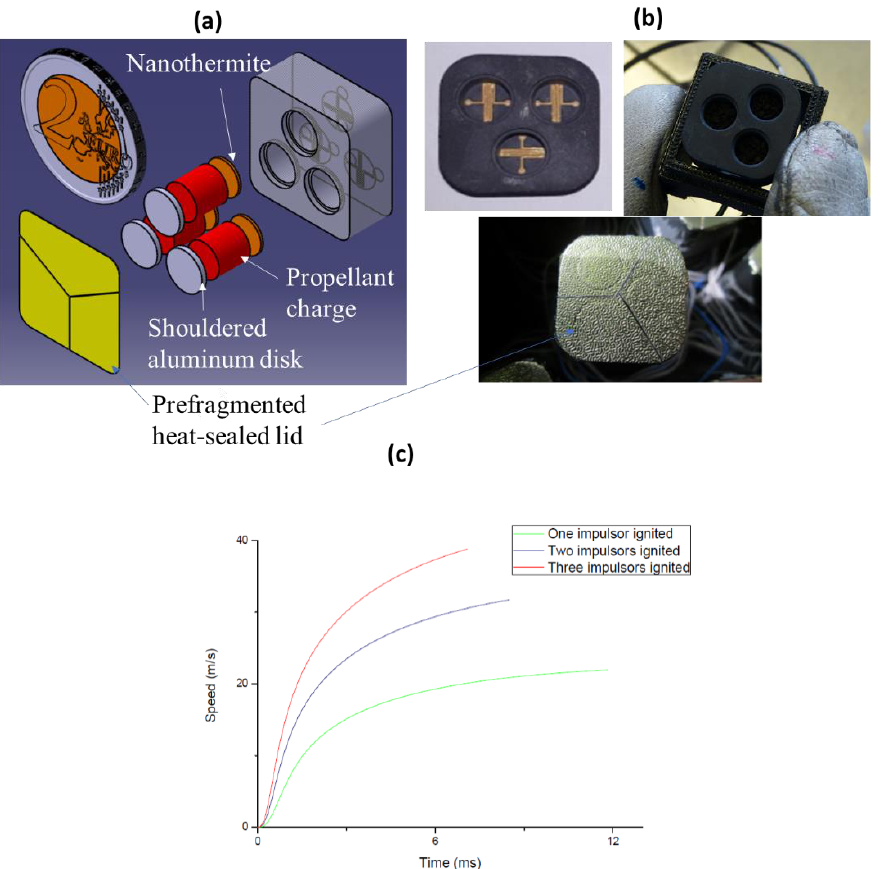
Figure 3. ( a ) Schematic of the triple plastronic impulsor concept made in MID technology, ( b ) a serie of photos of one metalized plastic prototype made of 3 impulsors (one is filled with propellant and sealed with the heat-sealed lid), and ( c ) the ejection speed as a function of the configuration: one, two or three ignited impulsors.